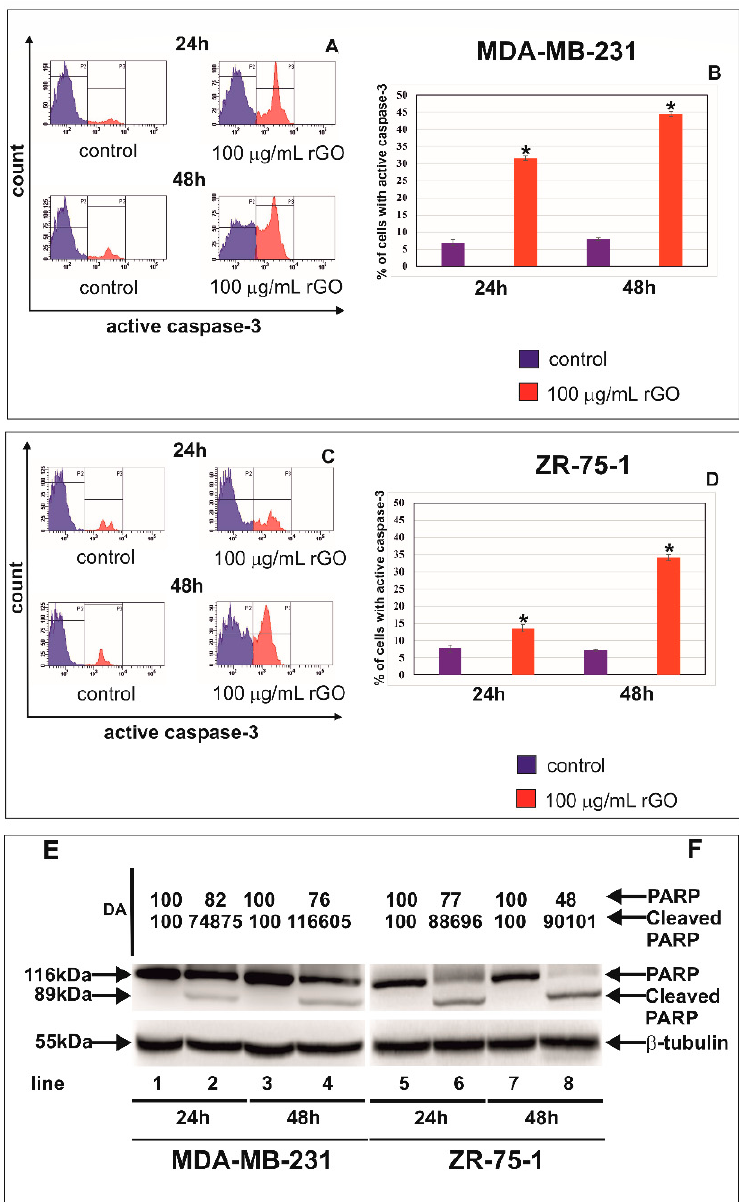
Figure 6. The effect of rGO on active caspase-3, PARP and cleaved-PARP expression in MDA-MB- 231 and ZR-75-1 cells. The cells were treated with 100 μ g/mL of rGO for 24 and 48 h. Panels A and B show the flow cytometry analysis of active caspase-3 in MDA-MB-231 ( A , B ) and ZR-75-1 ( C , D ) cells. Panels A, C show the representative histograms of MDA-MB-231 (A) and ZR-75-1 (C) cells. Panels B and D show the percentage of MDA-MB-231 ( B ) and ZR-75-1 ( D ) cells with active caspase- 3. Gate P2—populations of cells without of active caspase-3; gate P3—population of cells with active caspase-3. The right panel shows the percentage of MDA-MB-231 ( B ) and ZR-75-1 ( D ) cells with active caspase-3. The Western blot analysis of PARP and cleaved-PARP was performed in MDA- MB-231 ( E ) and ZR-75-1 cells ( F ) for rGO-treated cells (lines 2, 4, 6, and 8) and untreated control cells (lines 1, 3, 5, and 7). Samples containing 15 μ g of protein were submitted to electrophoresis and immunoblotting. Densitometric analysis ( E , F ) was presented as a relative fold change in comparison to untreated controls, where the expression level was set as 100. The expression of β -tubulin served as a control for protein loading. The mean values of analysis from three independent experiments ± SD are presented. * p < 0.05. Significant alterations are expressed relative to controls and marked with asterisks.